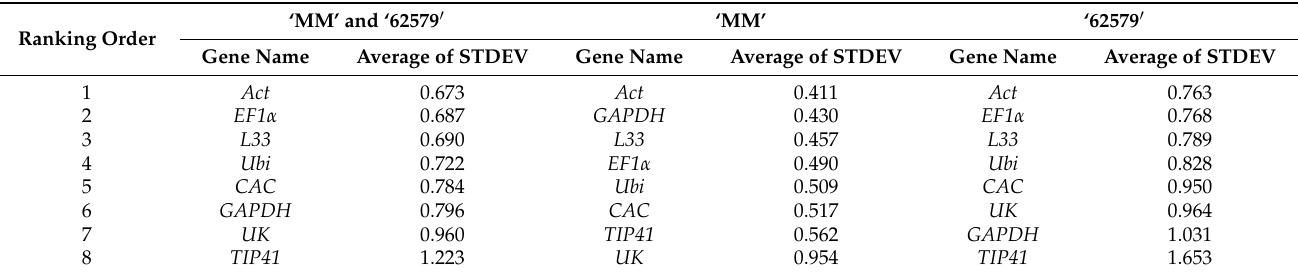
Table 4. Analysis results of the comparative ∆ CT method.